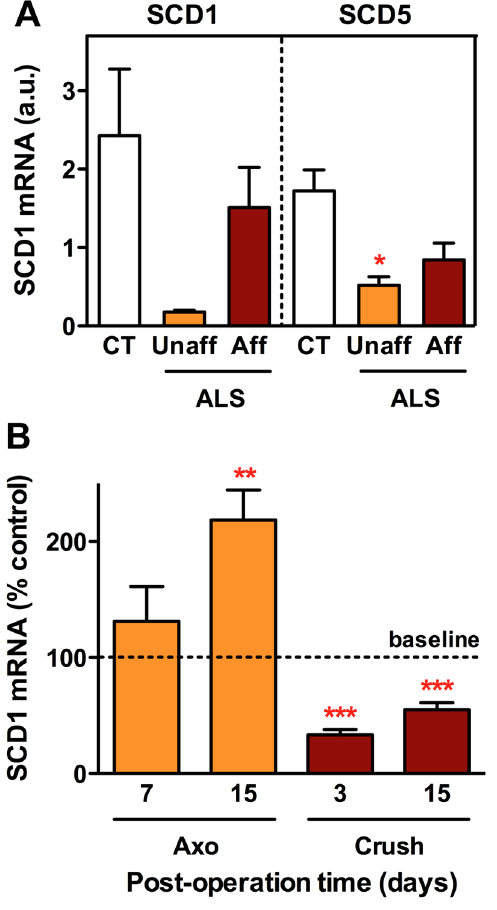
Figure 2. SCD1 expression in ALS patient muscle and after nerve injury. (A) Expression of SCD1 and SCD5 in deltoid muscle biopsies from ALS patients and healthy subjects (CT, white columns), as identified by microarray analysis of the database deposited at http:// www.ebi.ac.uk/arrayexpress/(accession number E-MEXP-3260) [12]. ALS samples were obtained from muscle not clinically or electromyography affected (Unaff, orange columns) and from muscle with advanced pathology, characterized by reduced strength and neurogenic electro- myography pattern (Aff, brown columns). * P , 0.05 (1-way ANOVA followed by Tukey’s multiple comparison test, n=4–10). (B) Expression of SCD1 in gastrocnemius following sciatic nerve axotomy (Axo) or crush at indicated post-operation days. Contralateral muscle expression is represented by 100% baseline. ** P , 0.01, *** P , 0.001 (One sample t- test,